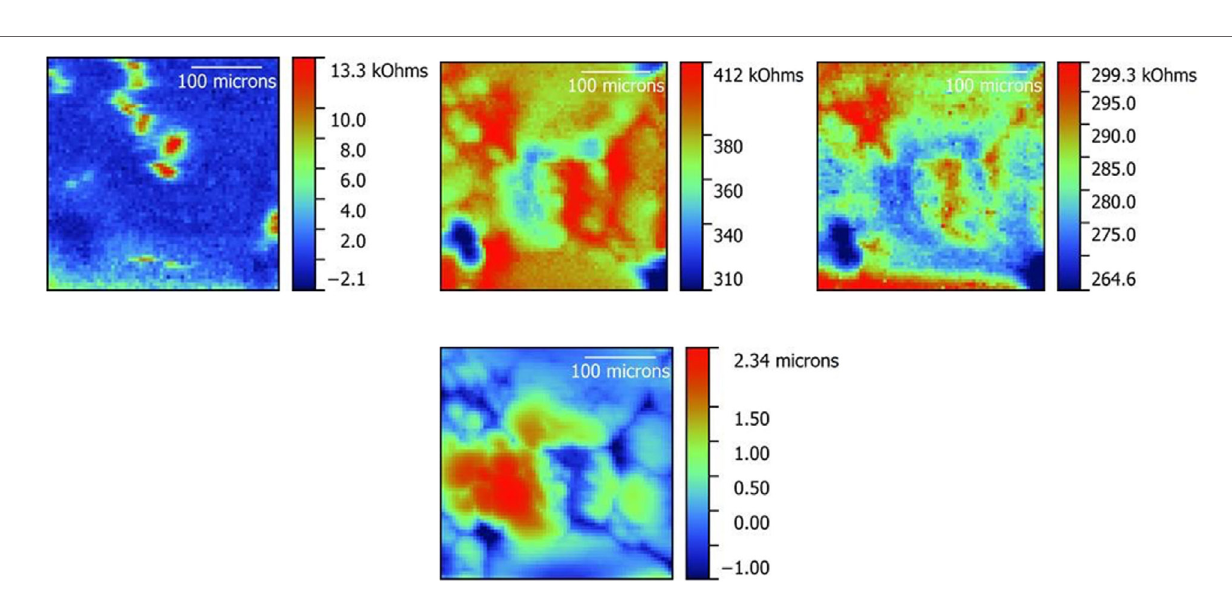
FigUre 5 | impedance maps obtained on a polished llZO pellet in ac-secM mode (left), ic-ac-secM mode (middle) and ac-secM mode with height tracking (right) . A topography map obtained from the ic-ac-SECM experiment is also shown below the ic-ac-SECM impedance map in the middle. A 325 μ m × 325 μ m area was studied.